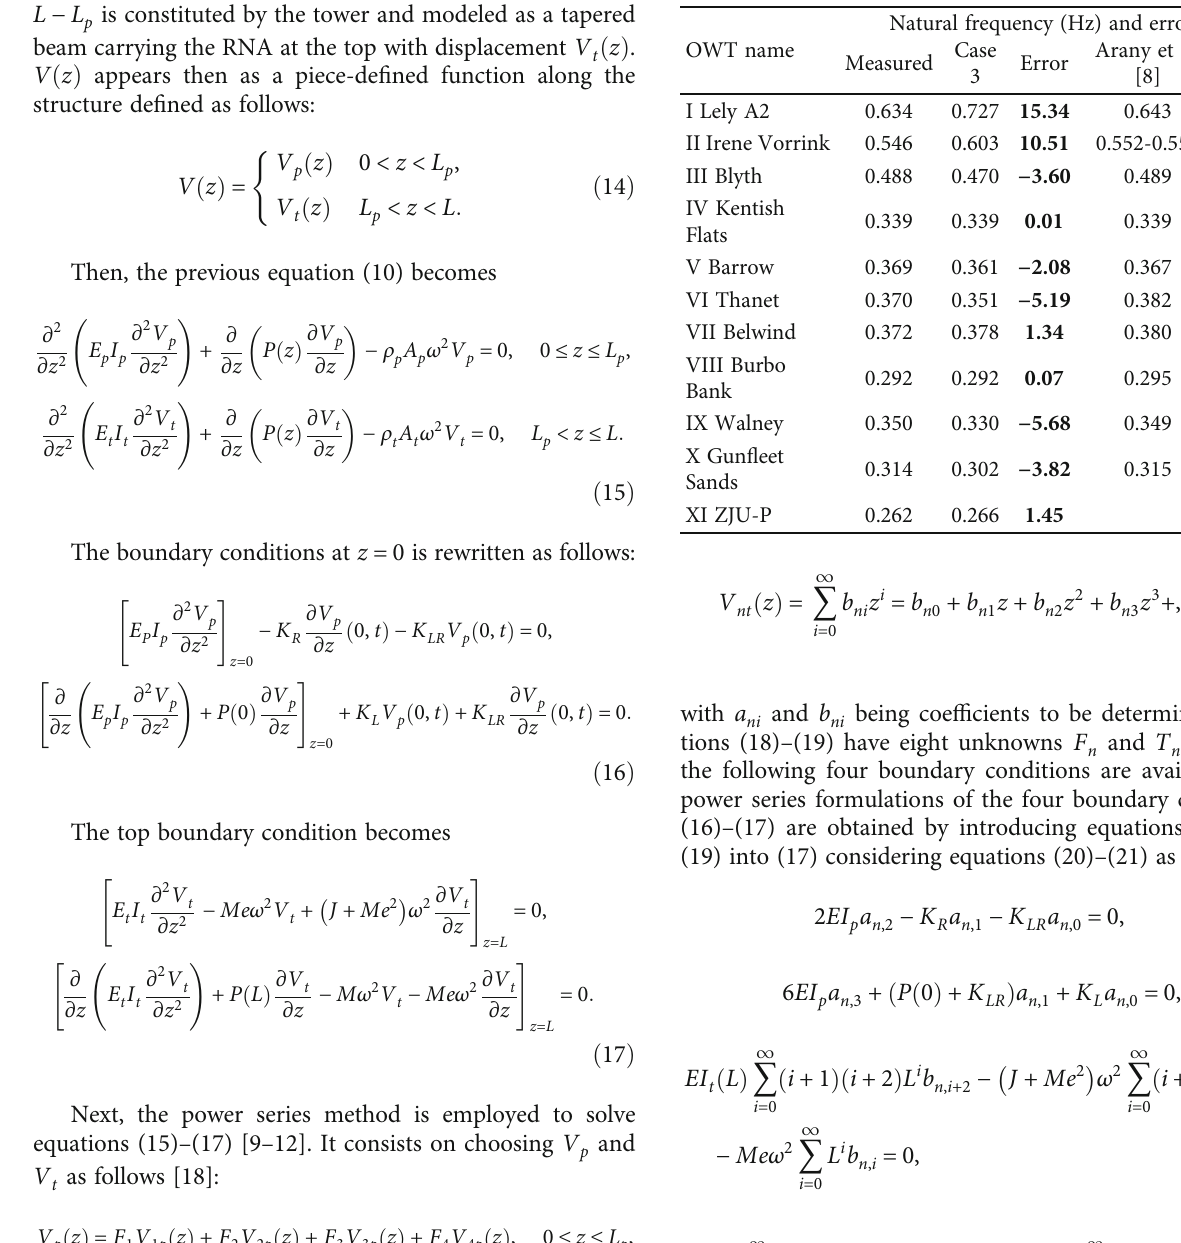
Table 4: Comparison of case 3 data and results from Arany et al.